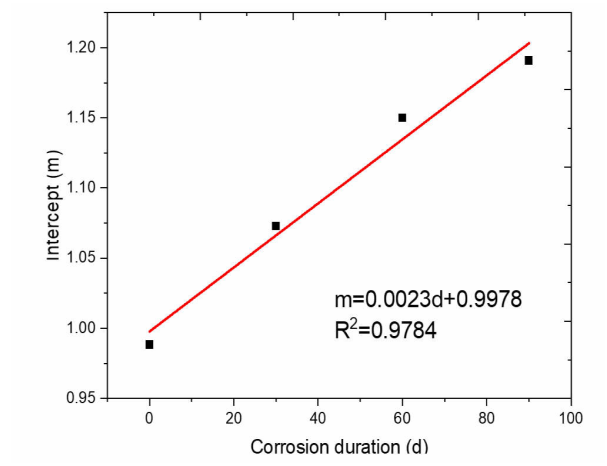
Figure 9. Fitting intercepts ( m ) in terms of corrosion duration